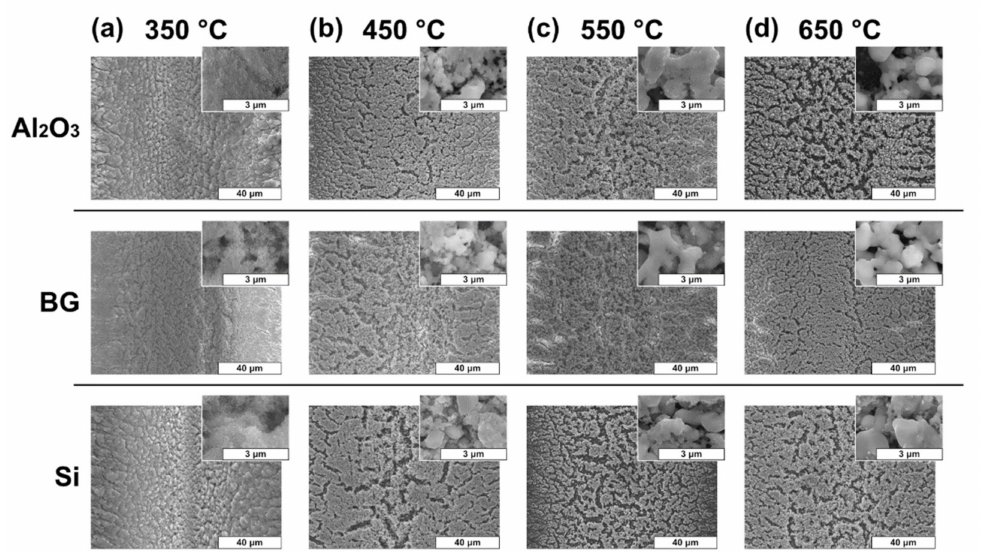
Figure 5. Scanning electron microscope (SEM) images of the surface of printed lines made of nanoparticles on alumina, borosilicate glass, and silicon substrates sintered in a reducing atmosphere at temperatures equal to ( a ) 350, ( b ) 450, ( c ) 550, and ( d ) 650 ◦ C,